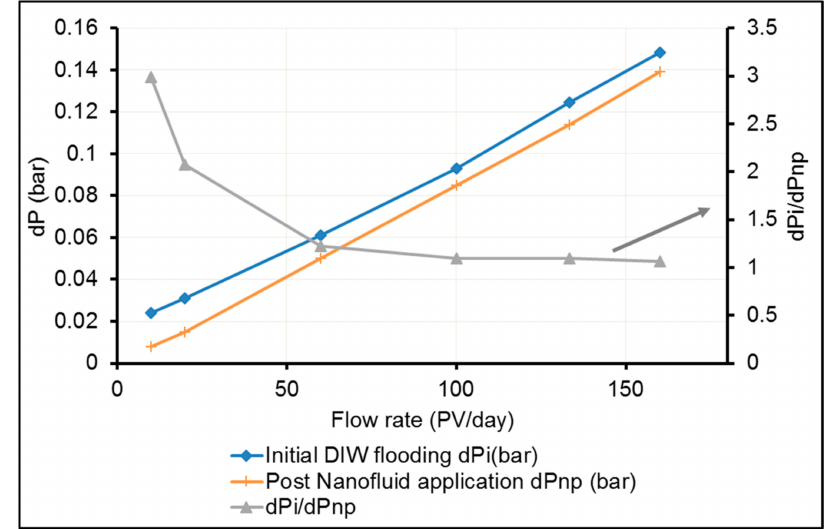
Figure 5. Pressure drop as function of injection rates (Experiment